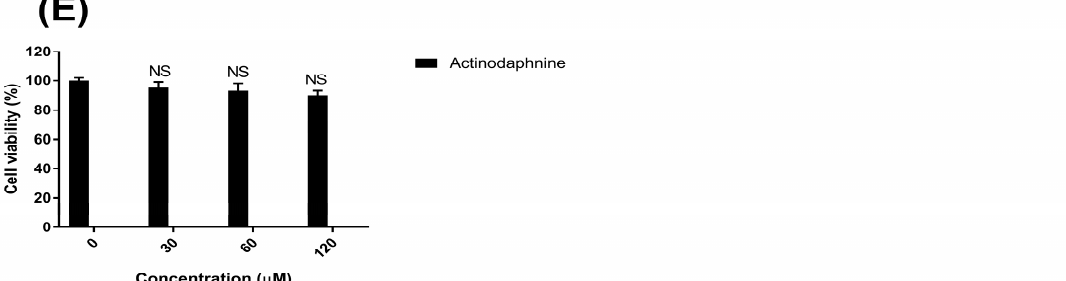
Figure 1. Cytotoxicity of selected compounds on Caco-2 cells. The cell viabilities were treated with various concentration of ( A ) acarbose, catechin, quercetin, rutin, ( B ) curcumin, 16-hydroxycleroda-3,13-dien-16,15-olide (HCD), ( C ) docosanol, tetracosanol, and ( D ) antroquinonol, berberine, and ( E ) actinodaphnine in Caco-2 cells measured via MTT assay and shown as the mean ± SD. * p < 0.05 when compared with the untreated control group (0 µM); NS, not significant.